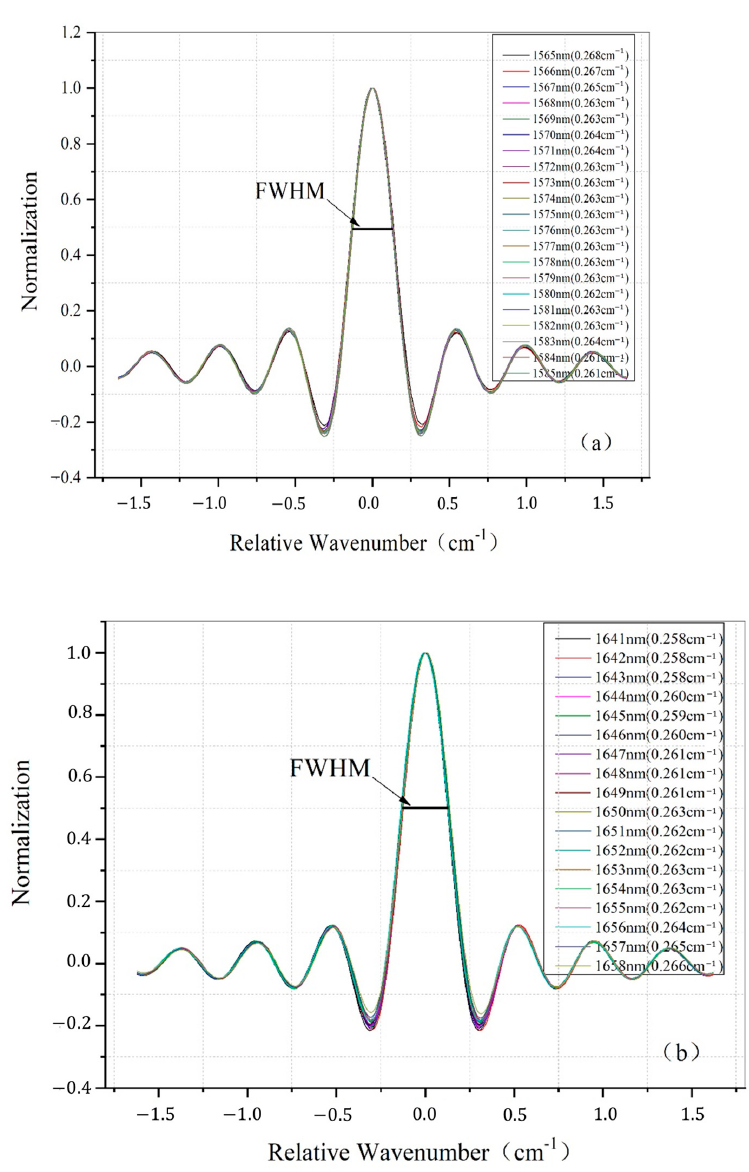
Figure 10. ILS test results: ( a ) CO 2 channel, and ( b ) CH 4 channel.